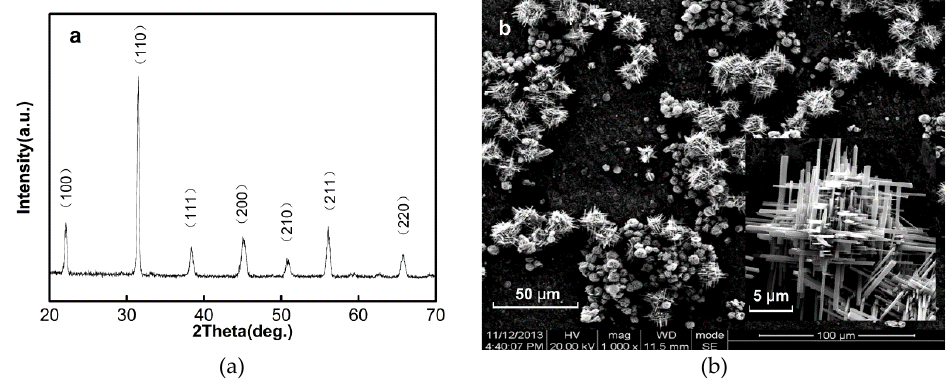
Figure 1. ( a ) X-ray powder diffraction (XRD) pattern of the (1− x )Pb(Mg 1/3 Nb 2/3 )O 3 - x PbTiO 3 (PMN-PT) nanorods; ( b ) scanning electron microscope (SEM) images of PMN-PT nanorods, and the inset indicates the corresponding higher magnification SEM image.